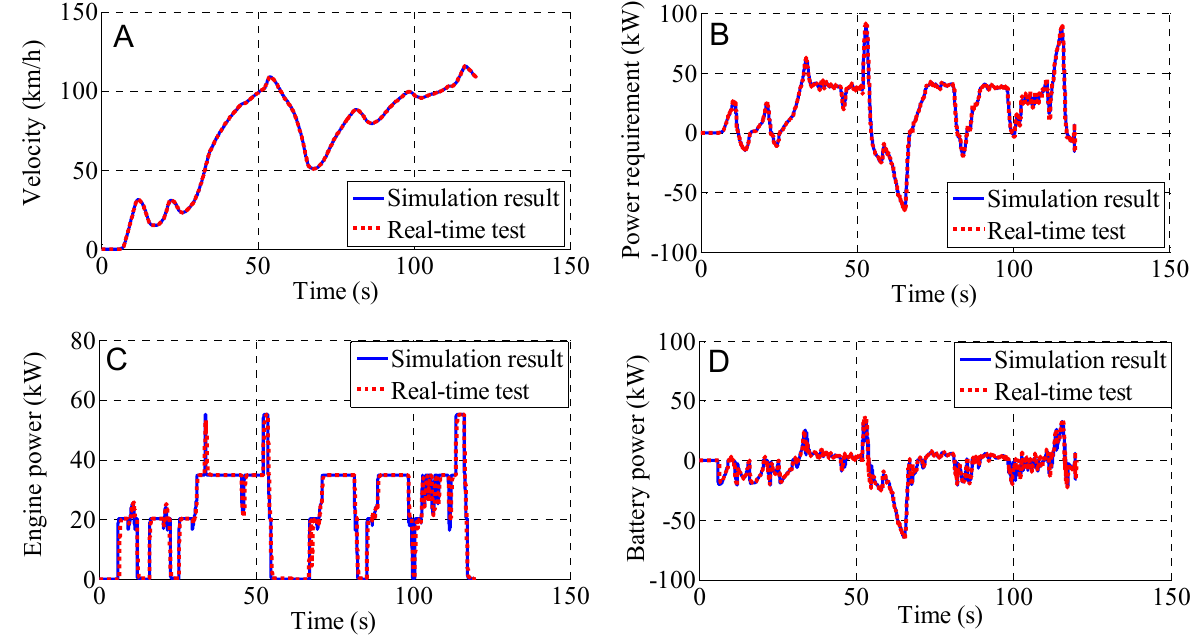
Figure 10. Comparison results of driver-in-the-loop real-time test and offline simulation: ( A ) Velocity; ( B ) Required power; ( C ) Engine power; ( D ) Battery